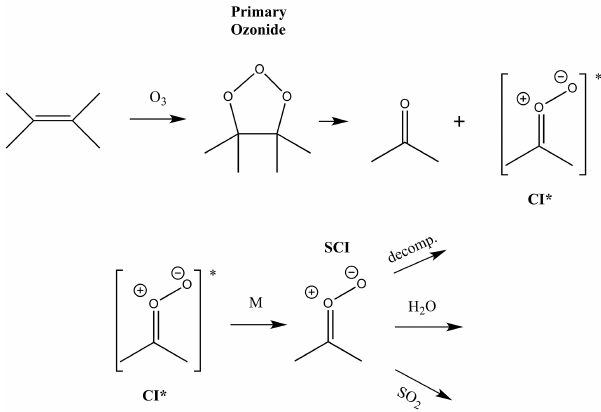
Scheme 1. Simplified generic mechanism for the reaction of Criegee intermediates (CIs) formed from alkene